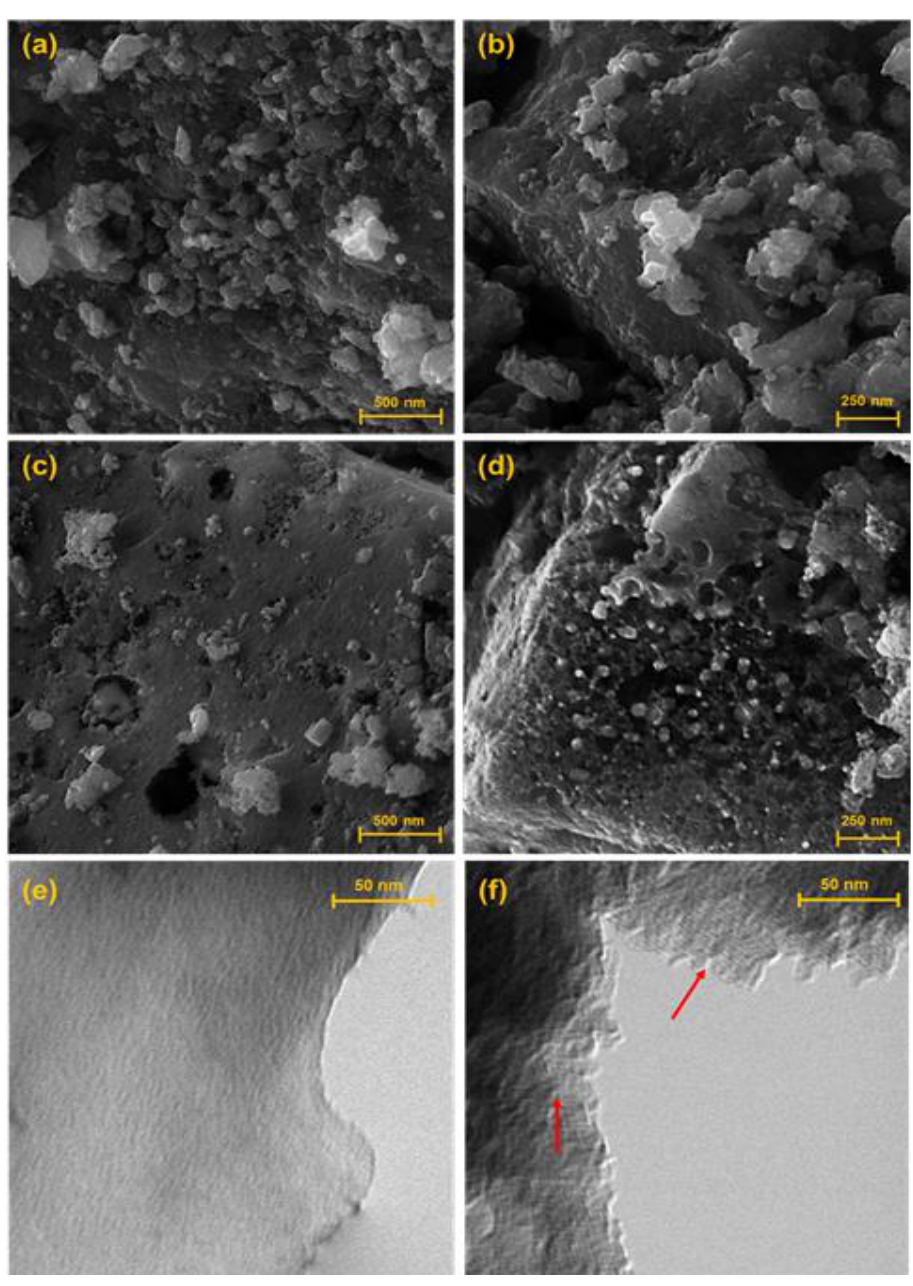
Figure 3. Scanning electron microscopy (SEM) images of XGL-C ( a , b ) and XGL-AC ( c , d ) and TEM images of XGL-C ( e ) and XGL-AC ( f